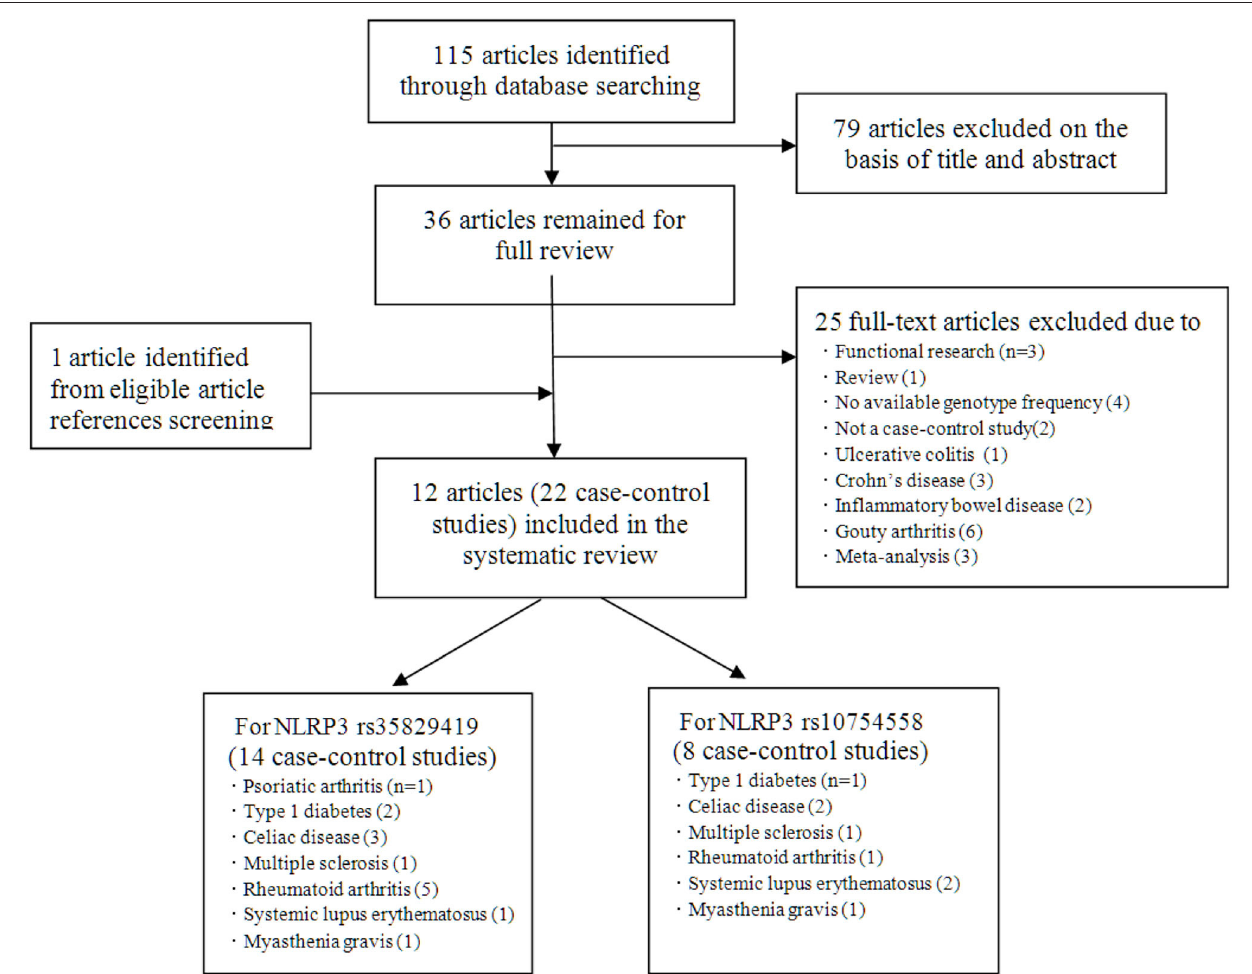
FIGURE 1 | Flowchart of study